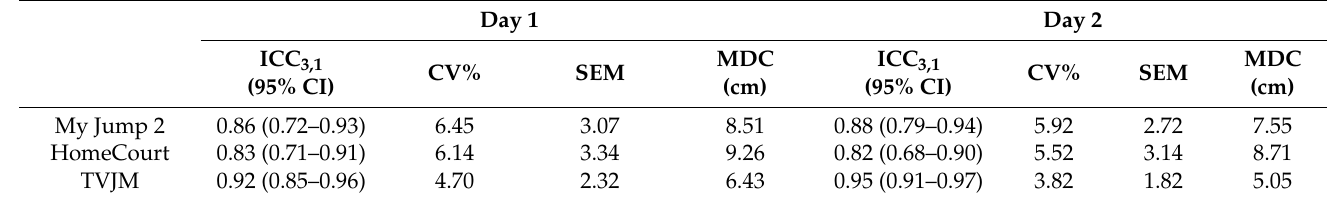
Table 3. Within-day test–retest reliability of CMJ measurement devices.